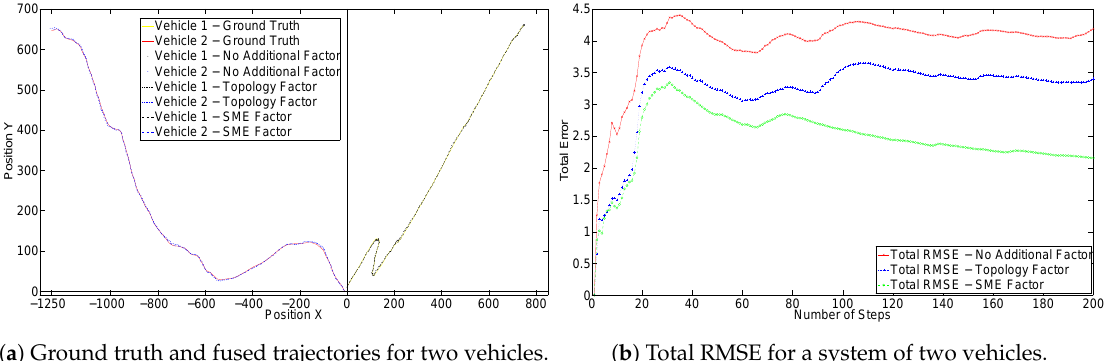
( b ) Total RMSE for a system of two vehicles. Figure 5. First set with GPS for two randomly simulated trajectories.